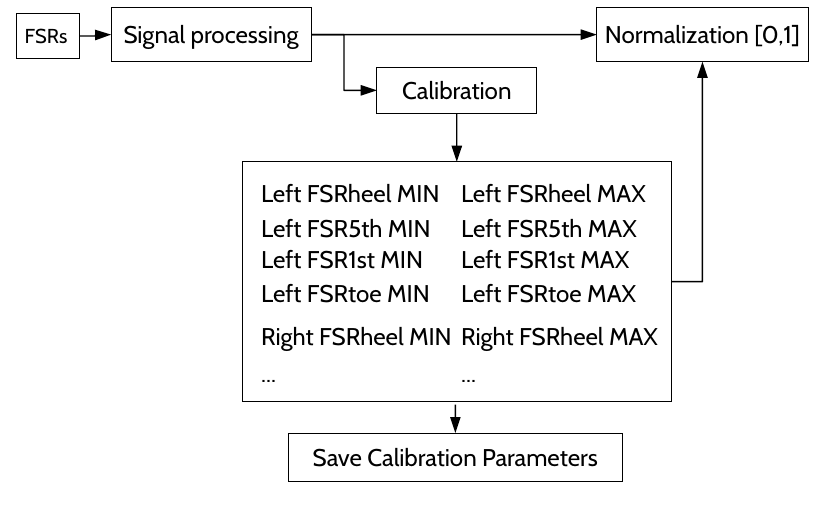
Figure 5. Sensor value